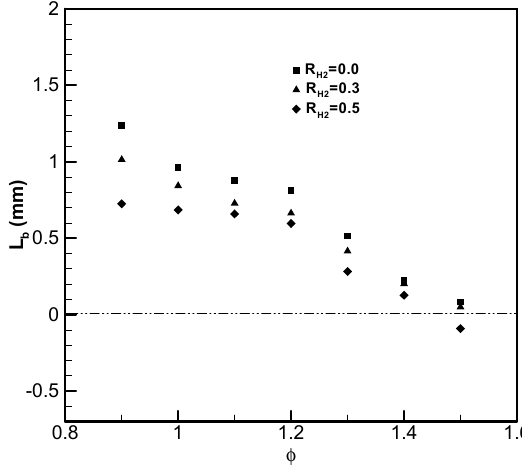
Figure 7. Effect of hydrogen addition on the Markstein number versus equivalence ratio.